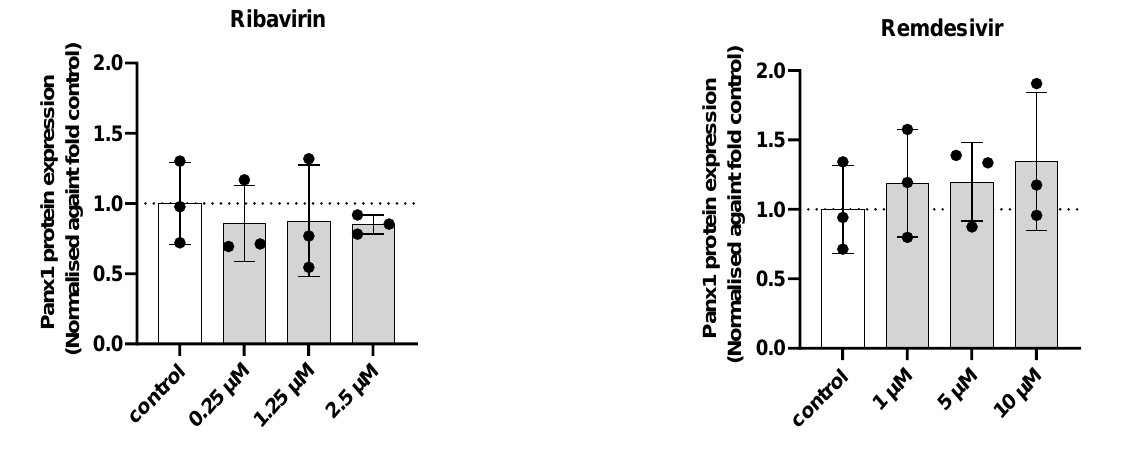
Figure 3. Panx1 protein expression after 24 h exposure of transduced Dubca cells overexpressing human Panx1 to the drug panel. Immunoblotting was performed, and data were extracted from the obtained blots using Image Lab 6.1 software. Data were normalised against total protein loading and the respective controls. Statistical analysis was performed using a parametric one-way ANOVA or non-parametric Kruskal–Wallis test in combination with a Dunnett’s or Dunn’s test, depending on the normality of the data distribution. The respective biological replicates are represented by separate dots in the graphs and by separate frames on the blot images ( N ). Data are expressed as mean ± standard deviation ( N = 3, n = 1) and visualised in separate graphs per drug with their respective blot images on top.